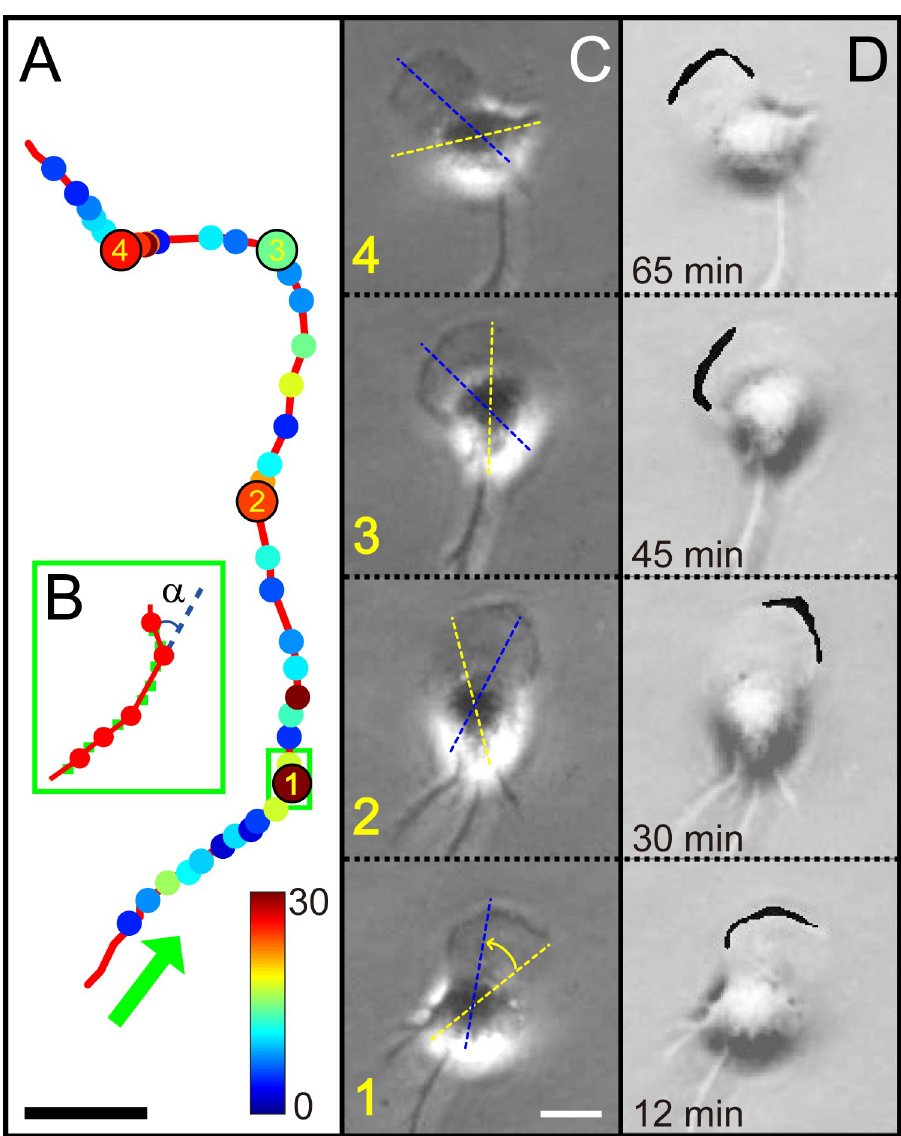
Fig 1. Zigzag turns made by a freely crawling microglia cell and alternating active zone of peripheral ruffles at its leading front. (A) A typical zigzag trajectory is smoothed by the third order polynomial function as a low-pass filtering, which is based on sequential images sampled at an interval of 15 s for 90 minutes (see Visualization 1). Individual turning points are designated by the dots of which colors show the turning angles. Four circles labeled with the numbers (1 to 4) correspond to the time points (12, 30, 45, and 65 minutes in that order). (B) Blown up image showing a sequence of small zigzag turns (green boxed area in (A). The green dots are the centroid positions before the filtering and the red dots mark turning events when a turning event occurs with an angle α . (C) Snapshot images showing the typical morphology of a crawling microglia obtained by PCM. Each image corresponds to one of the four labelled positions in (A). Dotted yellow and blue lines superimposed on images delineate the previous and new directions, respectively. (D) Images highlighting the active zone of peripheral ruffles along the leading front. For the sake of clarity, the active zone of peripheral ruffles is indicated with a saturated black (through thresholding and binarizing) and it is superimposed on (C) images. Scale bars in (A) and (C) are 10 and 20 μ m,